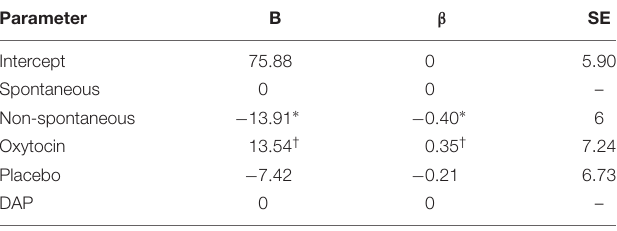
TABLE 13 | Standardized and unstandardized regression coefficients for each predictor in the significant model of the backward deletion multiple regression for percentage correct outcome.